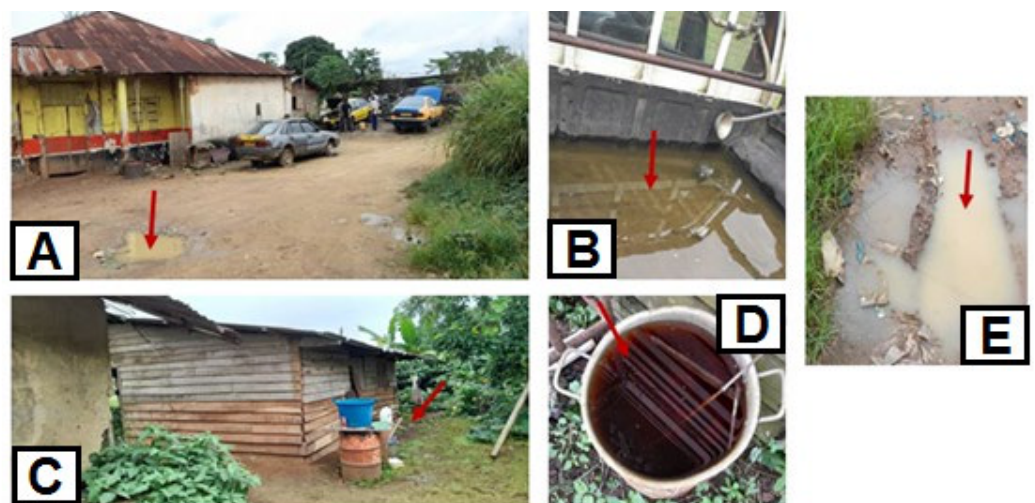
Figure 7. The environment of town. (A) represents the immediate environment of a garage found at « Haoussa quarter » with several surface groundwater spots with Anophelinae larval density between 100-500; (B) an abandoned truck filled with water and Anophelinae larval density of approximately 750 ; (C) The back view of a wood house with different water collection materials such as drums, bowls, and containers that harbored Culicinae larvae ; (D) abandoned pot behind a house with >500 Culicinae larvae ; (E) Stagnant water created by car tire with 150 Anophelinae